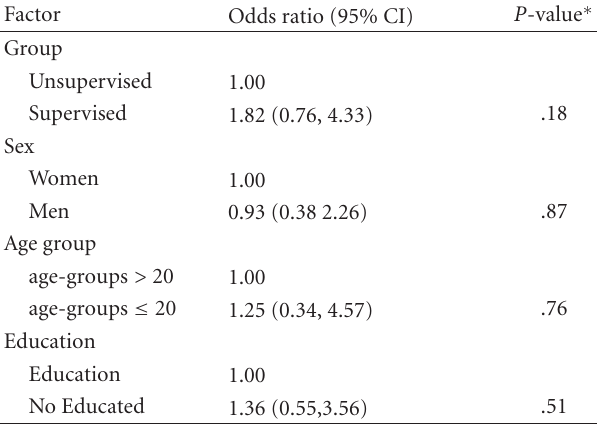
Table 2: Predictors of adherence to artesunate-amodiaqiune treat-